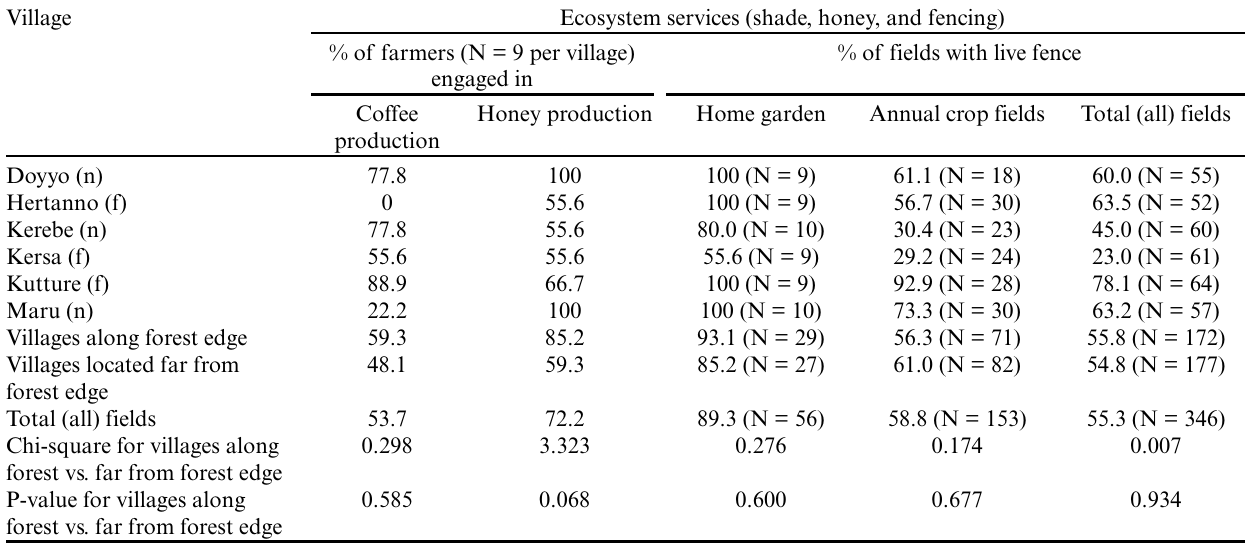
Table 4 . Issues related to farmers’ use of some ecosystem services from and related to trees and forest (in 2011). f: Villages located far from forest edge. n: villages located along forest edge. N: Sample size of farmers per village or number of fields per land-use type from which the percentages were calculated. Village Ecosystem services (shade, honey, and fencing) % of farmers (N = 9 per village) % of fields with live fence engaged in Honey production Home